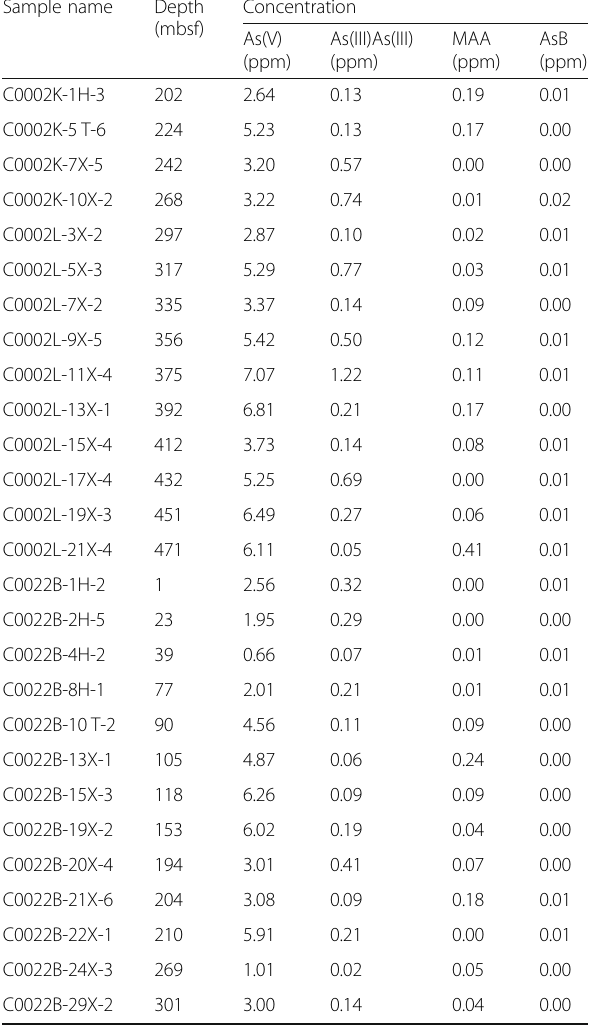
Table 3 Arsenic concentrations of soluble fractions extracted